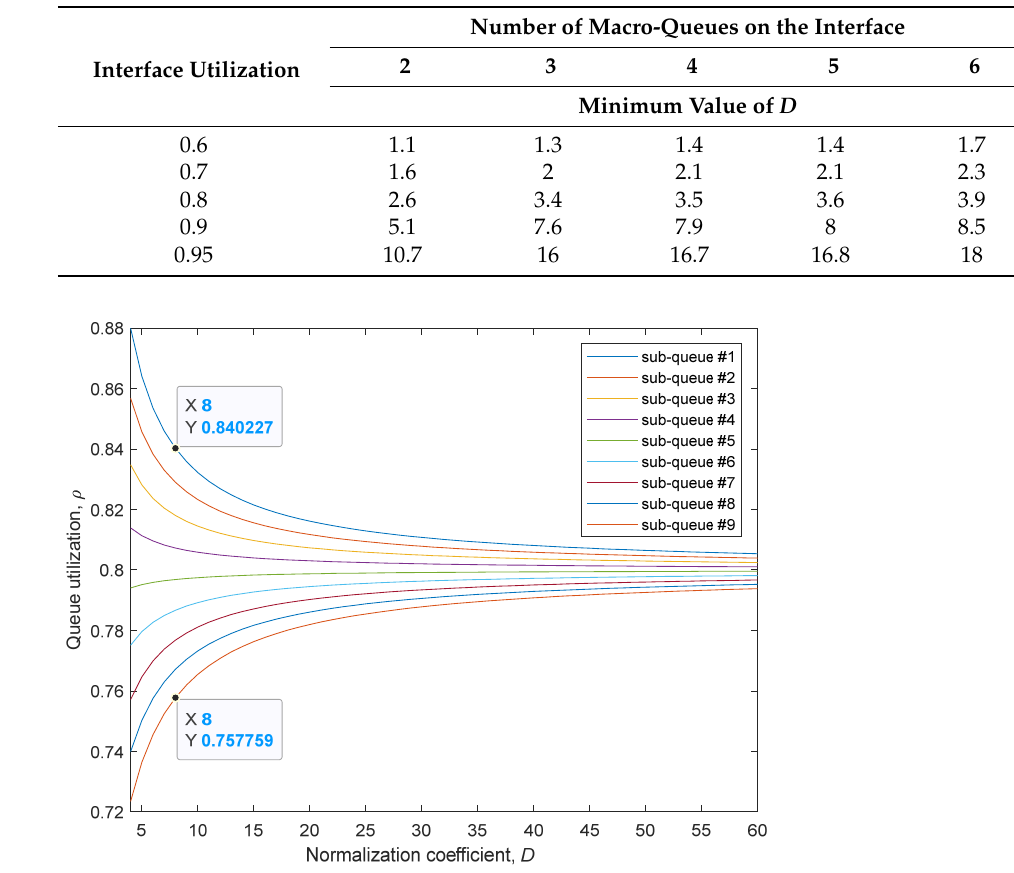
Table 8. Dependence of the minimum value D on the interface utilization and number of macro- queues organized on the interface.